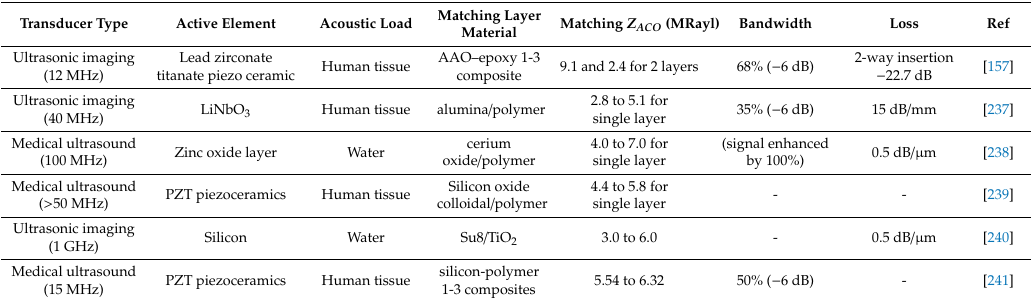
Table 5. Comparison of acoustic properties of passive composite and nanocomposite matching layer and their